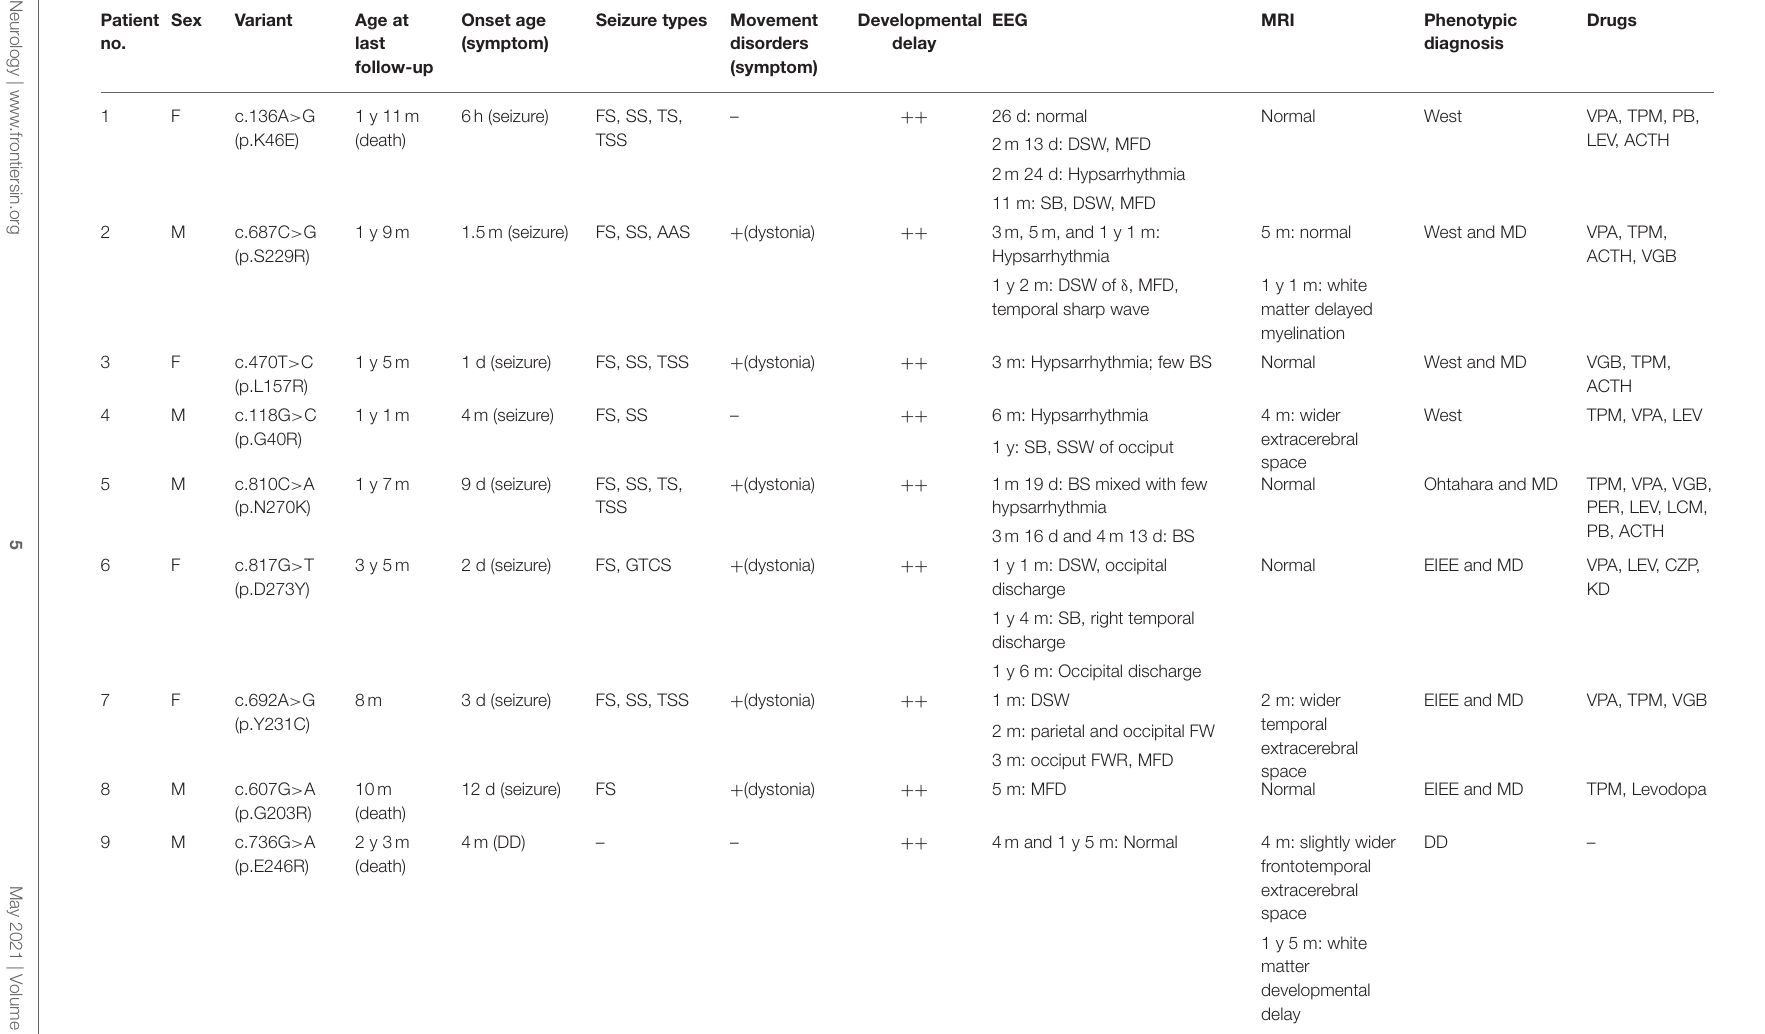
TABLE 1 | Genotypic and phenotypic features of 11 patients with GNAO1 variants. Patient